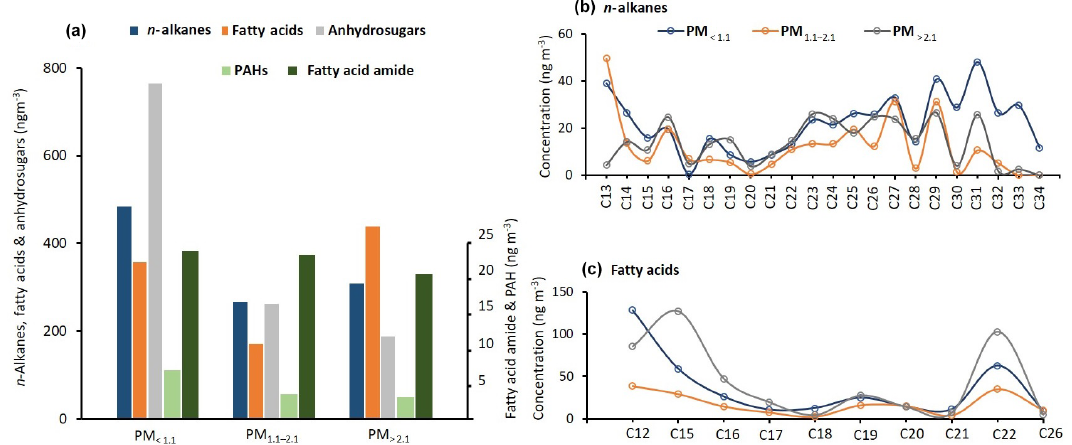
Figure 5. Size-segregated particulate-bound (a) organic aerosols and the difference in the molecular compositions of (b) n -alkanes and (c) fatty